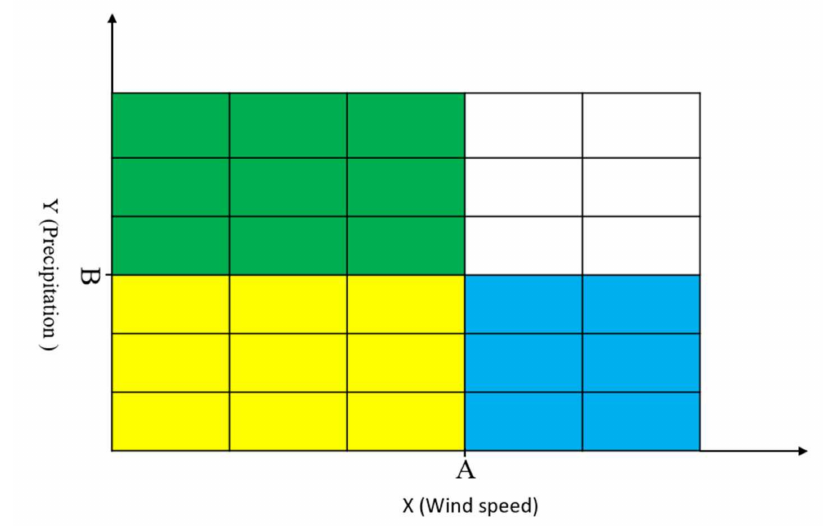
Figure 3. Planar projection of the joint probability